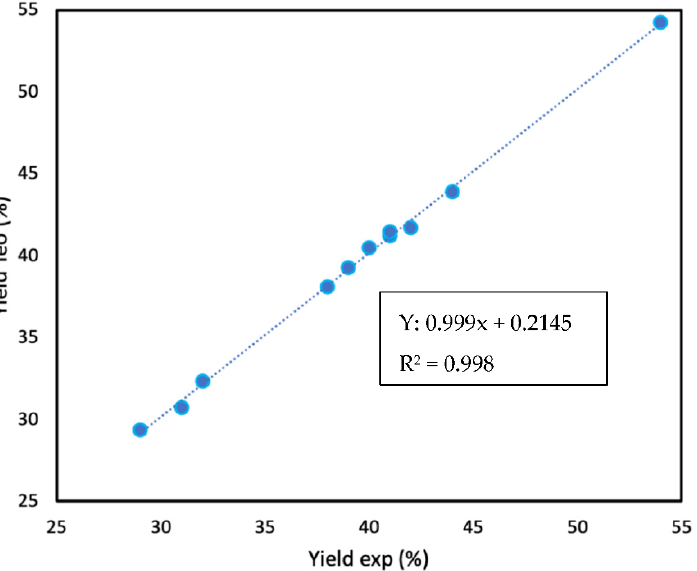
Figure 6. Experimental vs. theoretical yield. The data for the theoretical SiC yield were estimated from the following equation: yield (%) = 8.(OTI 1/2 ) +36.(%Ni) +34.(%Fe) +3.(%V).